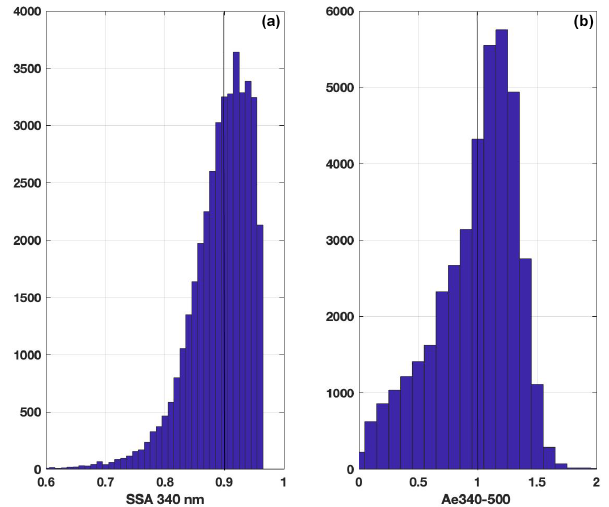
Figure 6. Frequency distributions of the values of SSA 340 (a) and Ang 340 − 500 (b) for the entire investigation period. The median val- ues used as threshold values to separate the different classes are highlighted with vertical black